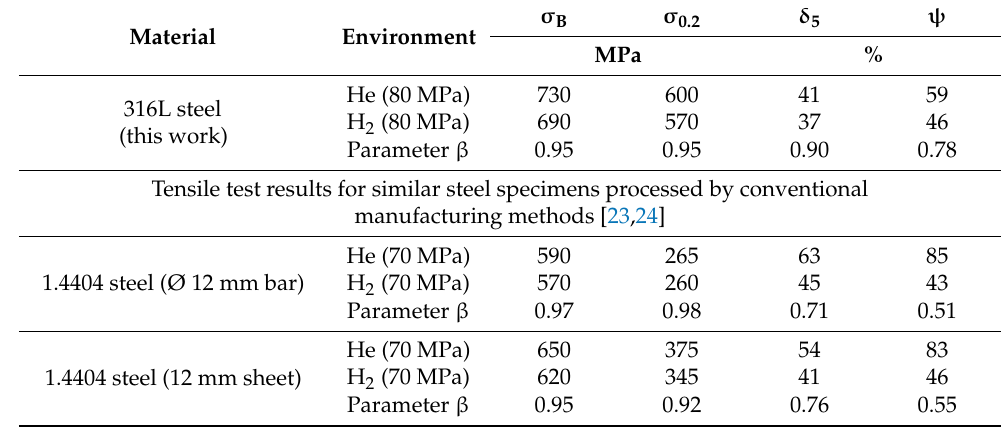
Figure 4. Model assembly for high-temperature hydrogen permeability tests: 1, 2—tubes; Figure 4. 3—researched specimen (membrane).